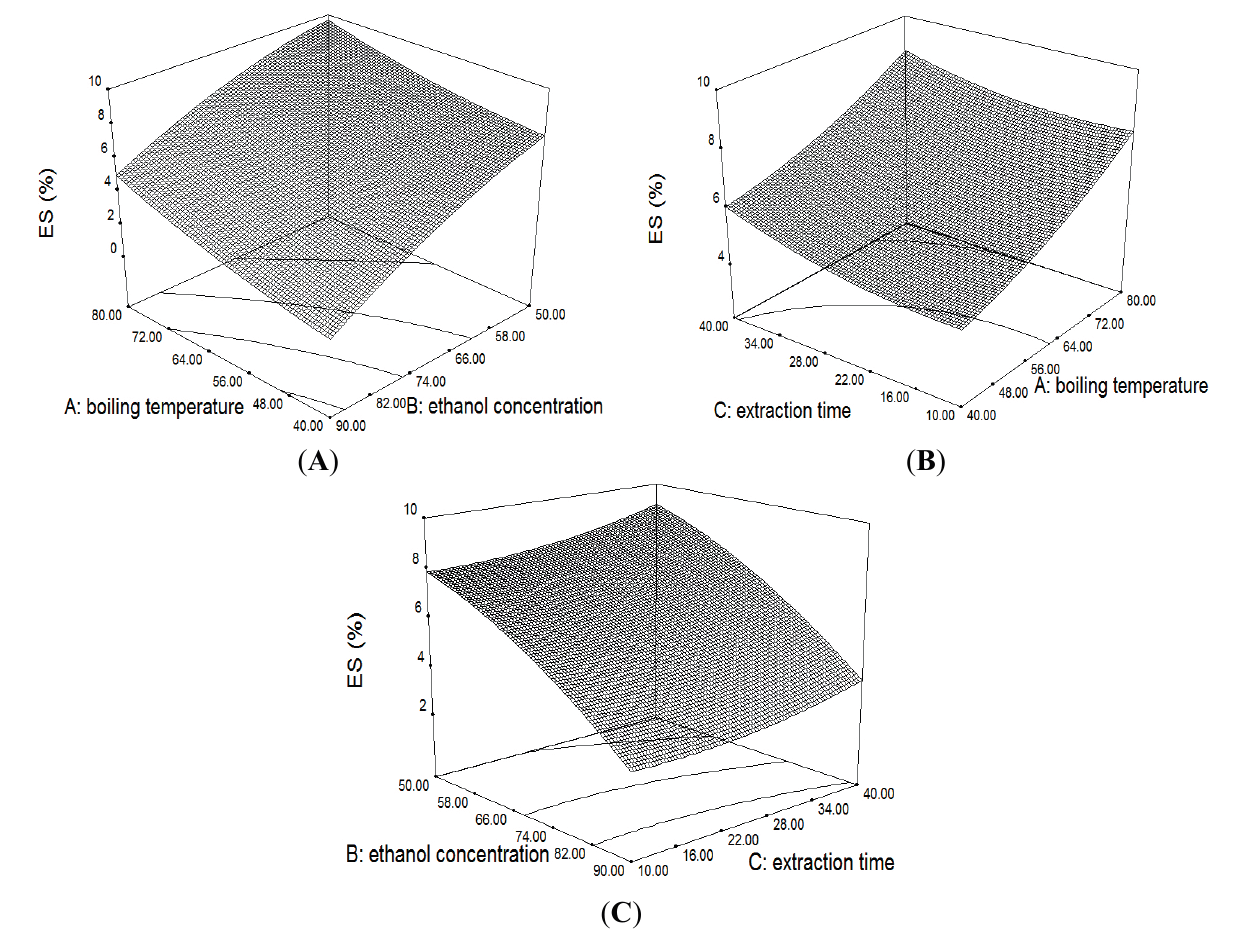
Figure 5. 3D surface and contour plot showing the effect of variables on the yield of